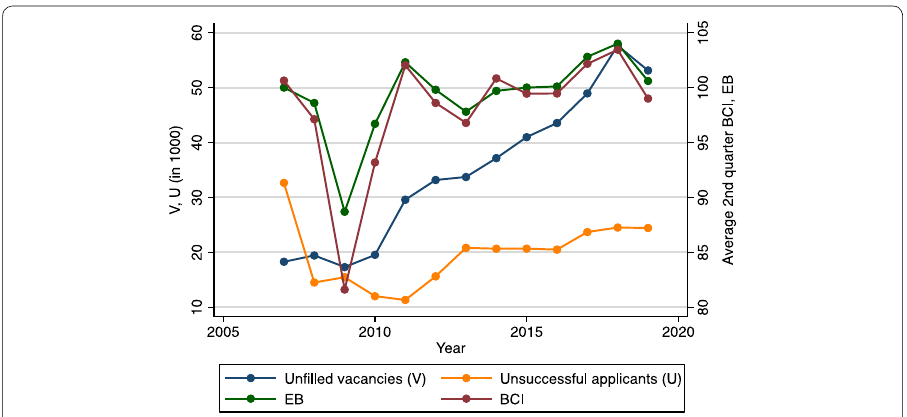
Fig. 6 Number of unfilled vacancies, unsuccessful applicants, ifo Business Climate Index (BCI), and ifo Employment Barometer (EB; 2007–2019). Source: Apprenticeship market statistics 2007–2019, Federal